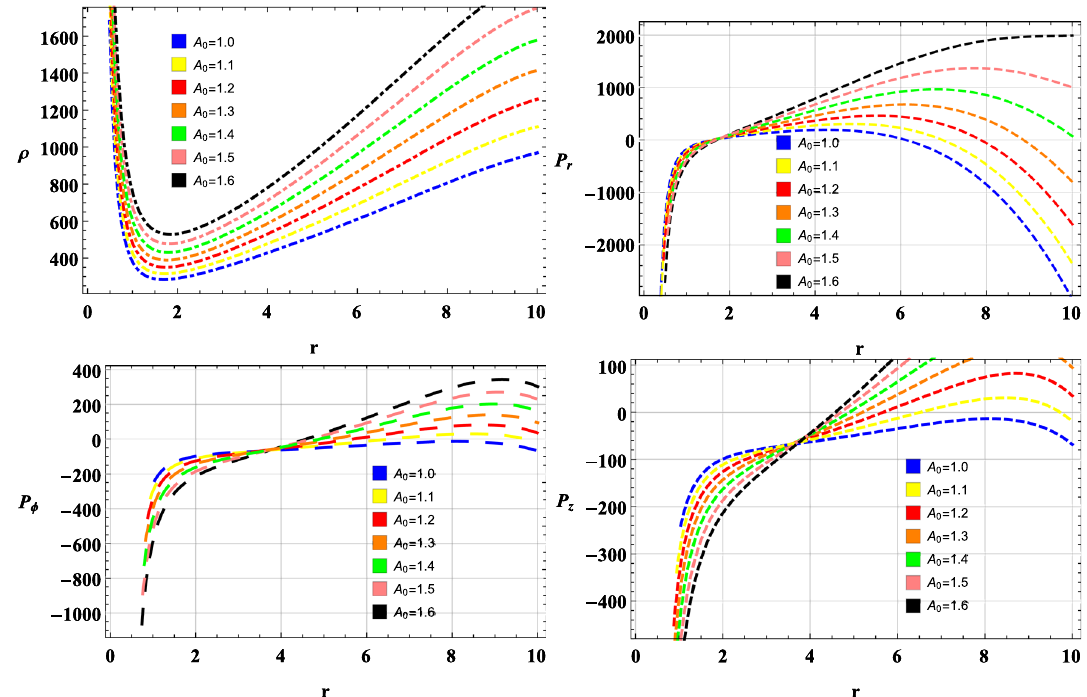
Fig. 13 This panel illustrate the variation of density (MeV/fm 3 ) , p r (MeV/fm 3 ) , p φ (MeV/fm 3 ) and p z (MeV/fm 3 ) w.r.t r . CASE (D)